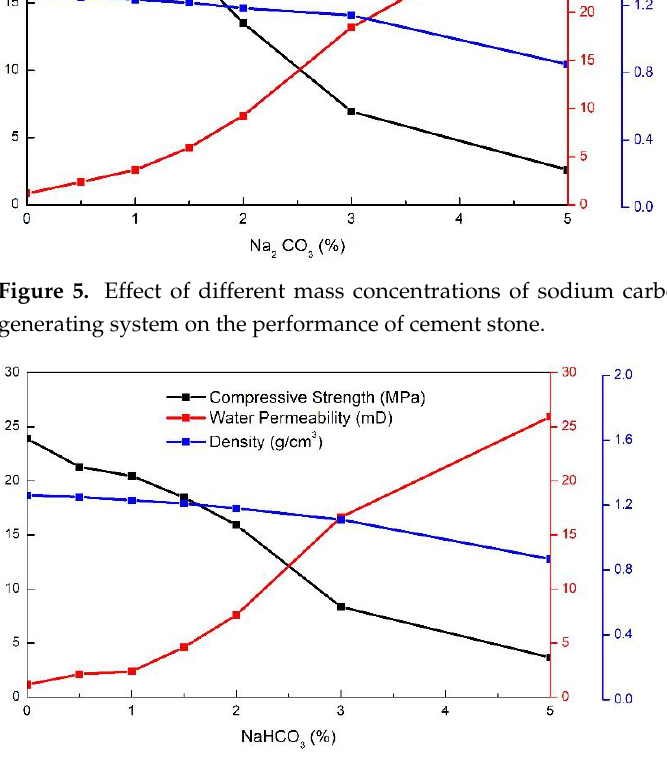
Figure 5. Effect of different mass concentrations of sodium carbonate + aluminum sulfate gas-gen- erating system on the performance of cement stone.